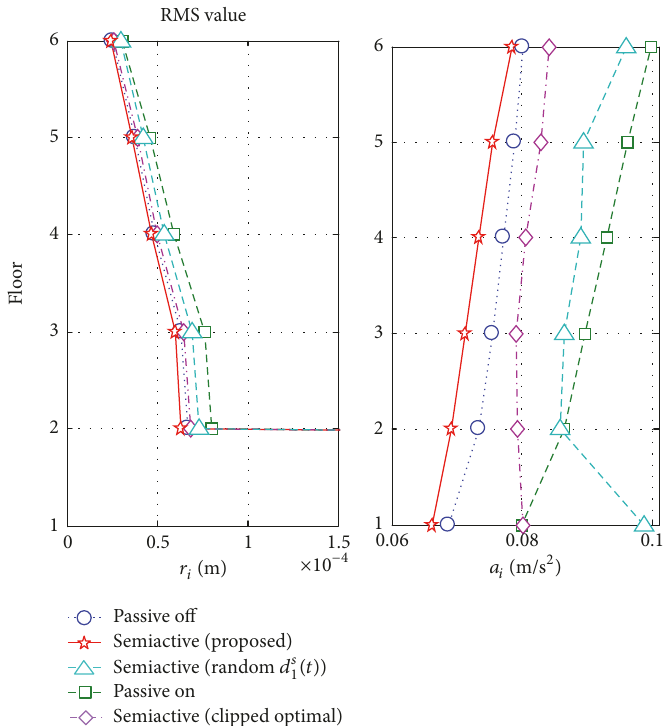
Figure 16: Simulation results for the Kobe NS (1995) earthquake disturbance; RMS values of the relative displacement between neighboring floors and absolute acceleration of each floor.